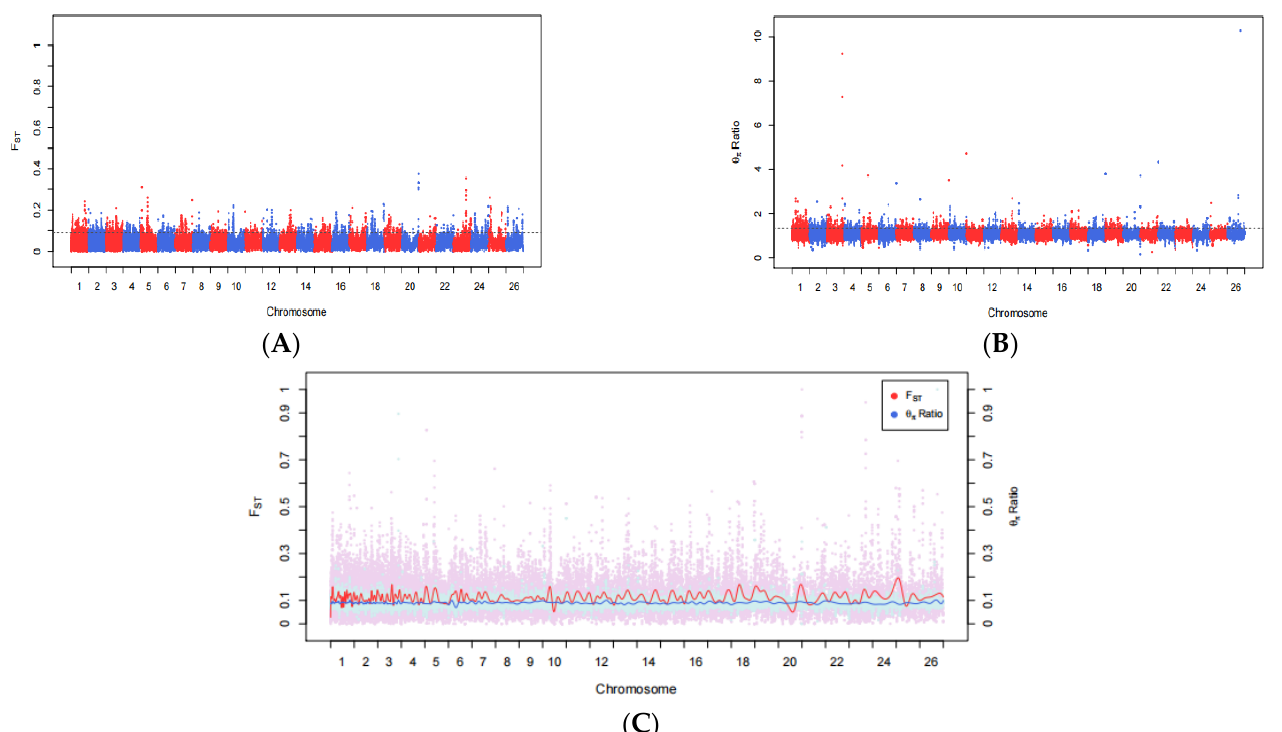
Figure 2. Analysis of selection signal distribution on sheep autosomes. ( A ) Manhattan map of Fst; ( B ) Manhattan map of θπ ratio; ( C ) Manhattan map of Fst and θπ ratio joint analysis.